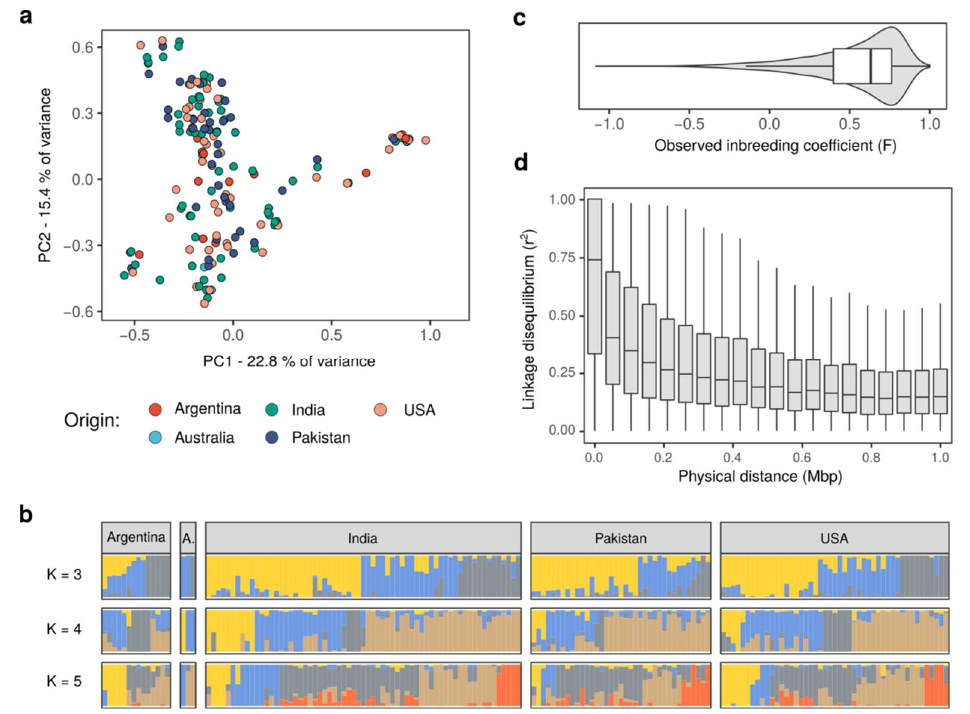
Figure 2. Reference genotype panel identifies the genetic structure of the guar populations. ( a ) Principal component analysis of the guar genotype dataset. Each point on the plot corresponds to one sample. Color of the points corresponds to the origin of the sample. ( b ) Bar plots representing results of the ADMIXTURE analysis for K = 3 (top), K = 4 (middle), and K = 5 (bottom). Color of the bar corresponds to one of K ancestral populations, height of the colored bar corresponds to the relative contribution of the ancestral population to the genotype of each sample. ( c ) Violin plot and box plot representing the distribution of the Inbreeding coefficient values computed for each variant in the guar genotype dataset. ( d ) Boxplots representing the linkage disequilibrium (r 2 ) values for pairs of SNPs located at indicated physical distance in the same contig of the reference genome assembly.